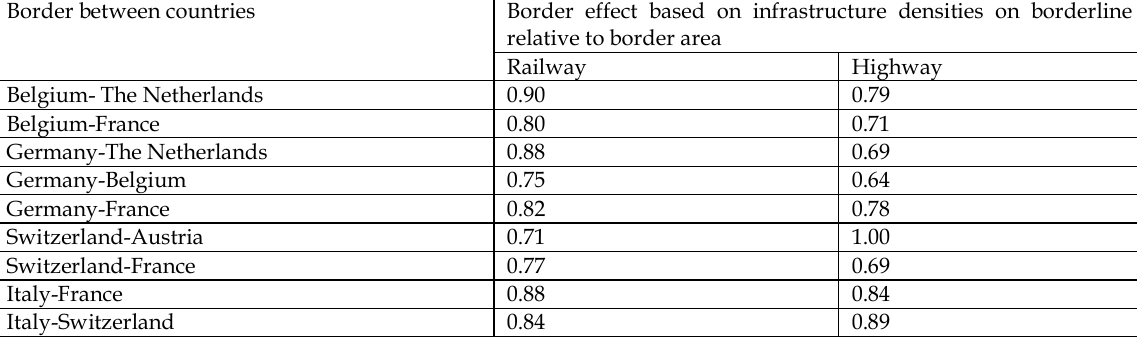
Table 3. Border effects (B4) for rail and highways based on infrastructure densities Border between countries Border effect based on infrastructure densities on borderline relative to border area